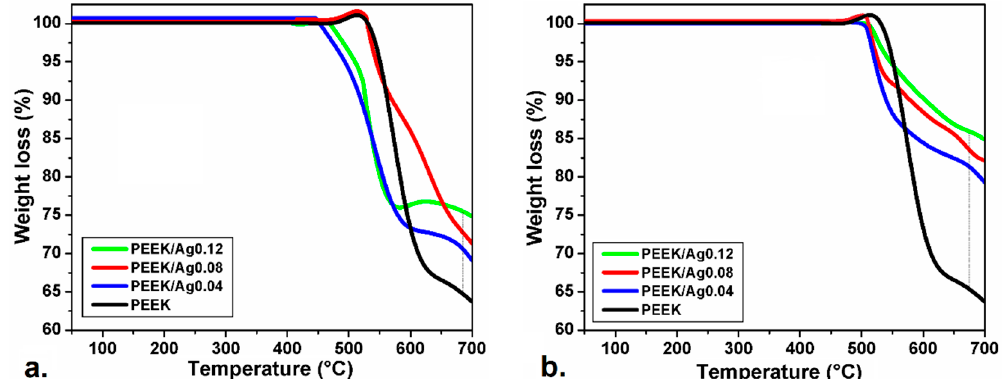
Figure 6. Thermogravimetric analysis (TGA) of uncoated PEEK, PEEK/Ag0.04, PEEK/Ag0.08 and PEEK/Ag0.12 samples (a) with one coating layer and (b) with two coating layers.